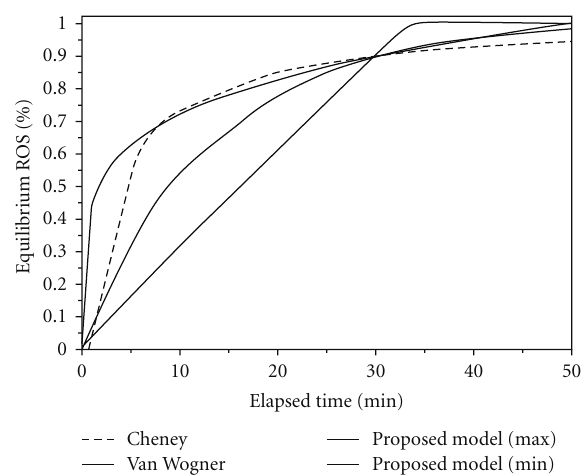
Figure 3: Theoretical fire spread rate acceleration curves from point-source ignitions show asymptotic increase in spread rate over time toward an equilibrium rate (from [43]).